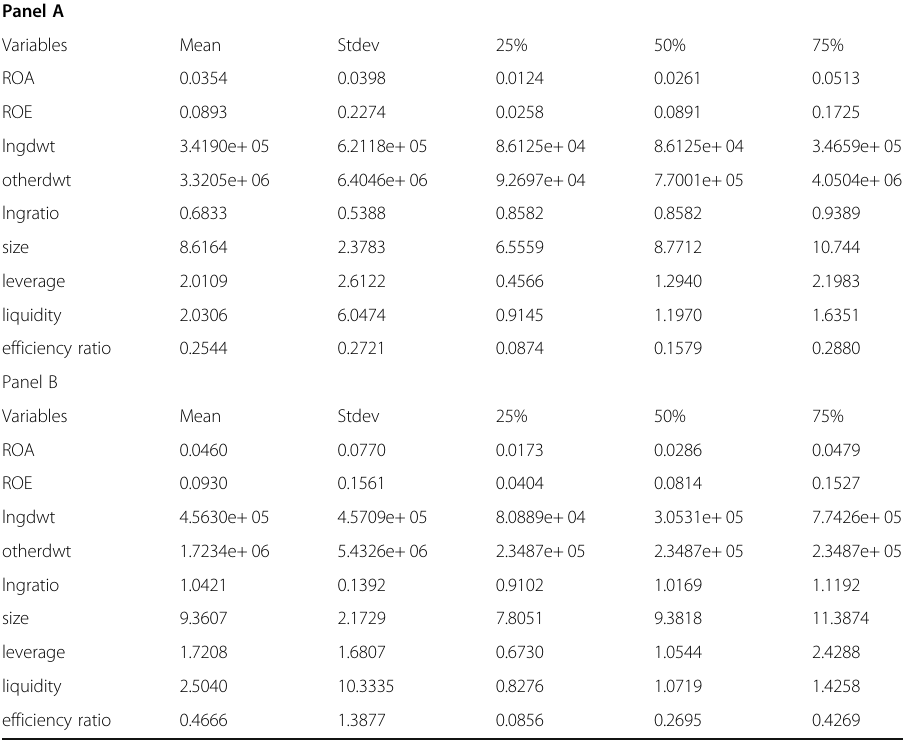
Table 2 Summary statistics of key variables of shipping firms used in this study (% denotes